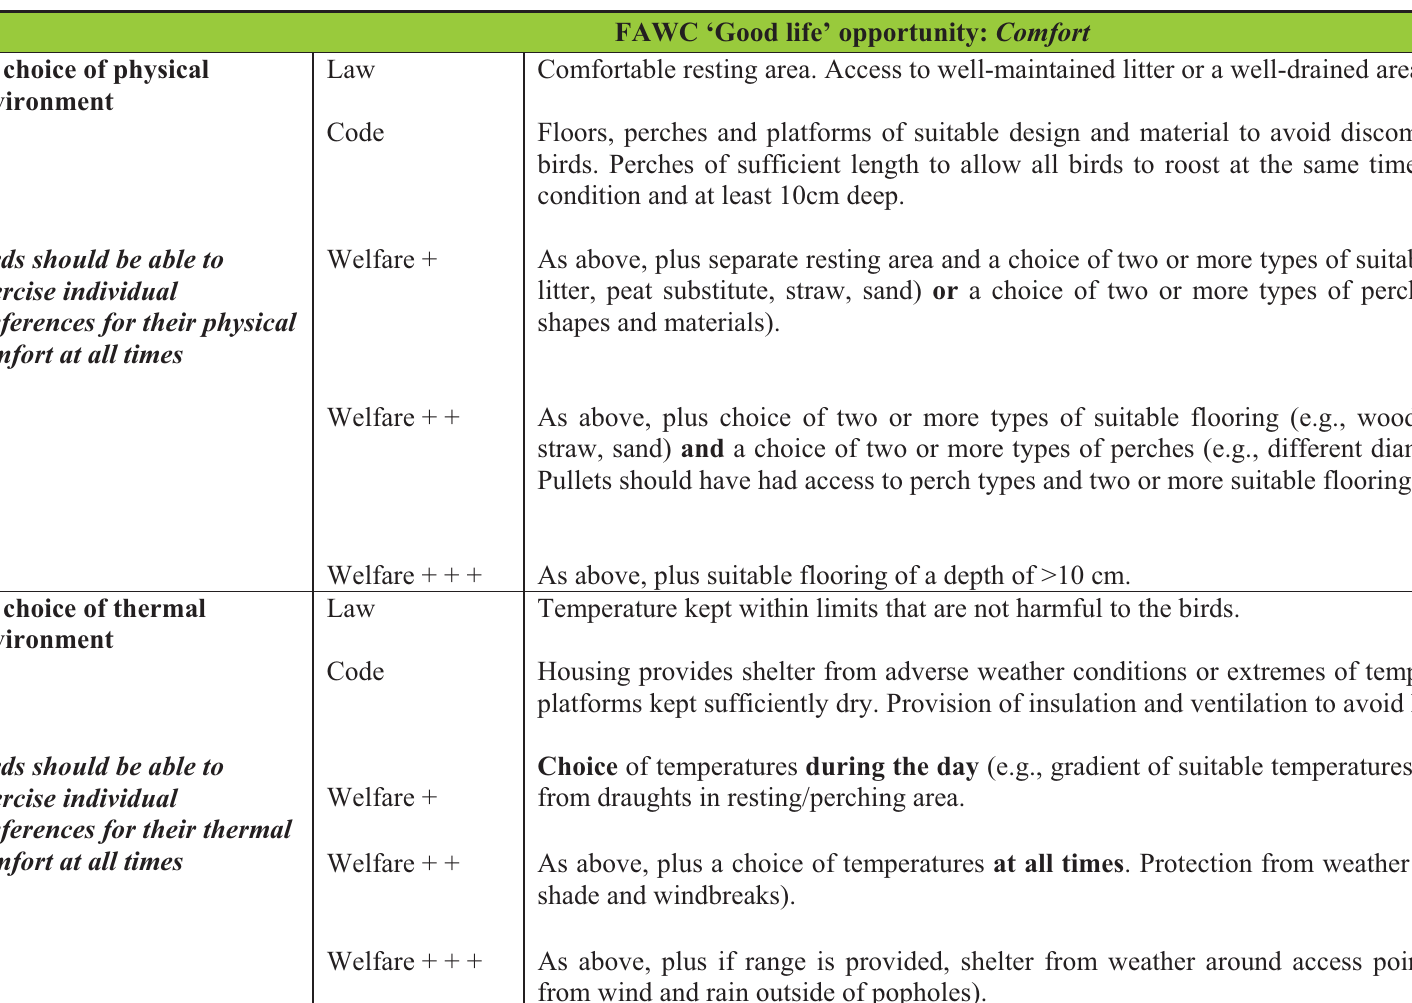
Table 1 . Laying hen resource tiers to assess compliance with legislation, code of practice and increasing levels of ‘good life’ opportunities (welfare +, ++ and